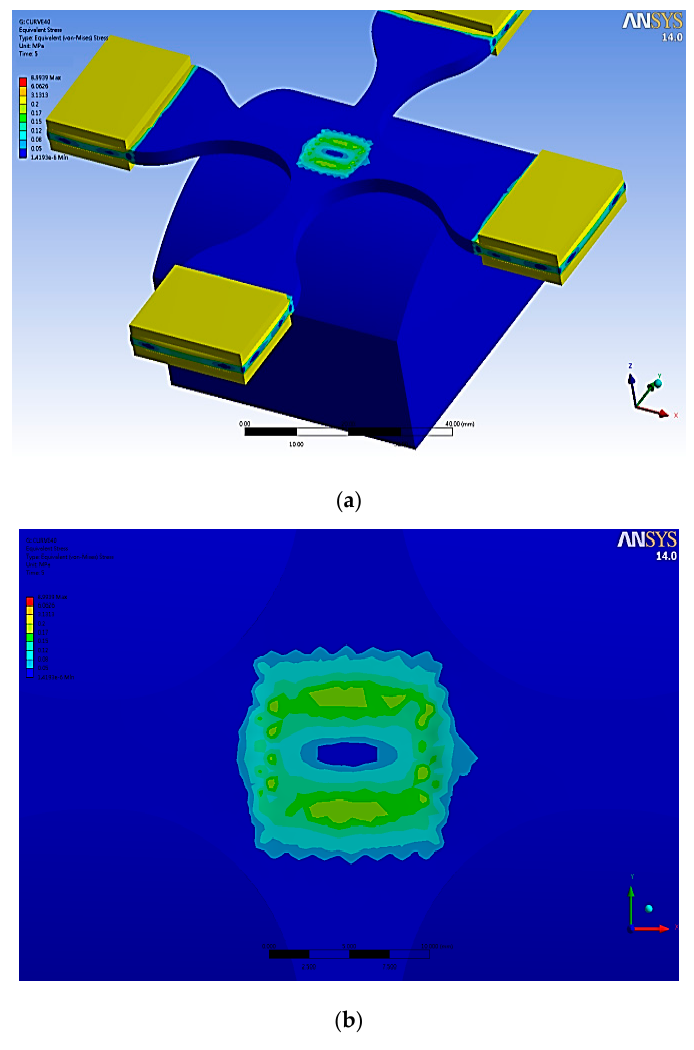
Figure 13. Cross microstructure mold von Mises stress distribution. ( a ) Full view; ( b ) partial view.